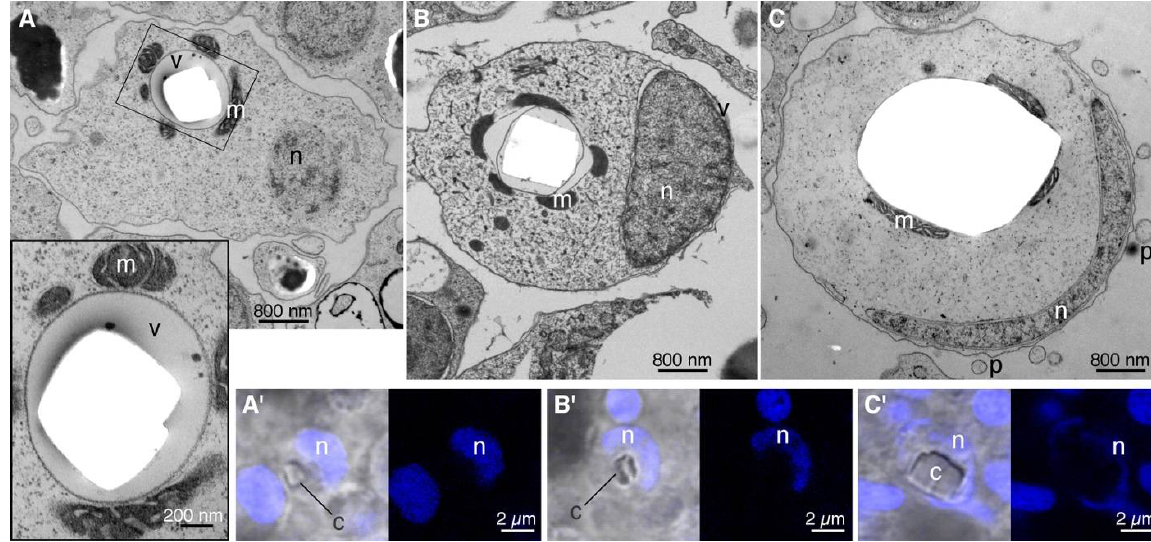
Figure 1. Transmission electron and light microscopy of developing and mature crystal cells. ( A ), ( B ), ( C )—ultrathin sections in TEM. ( A’ ), ( B’ ), ( C’ )—light microscopy of Hoechst labeling (blue) shown superimposed on DIC image (left) and separately (right). ( A )—an early stage of crystal cell development characterized by a very small crystal (<800 nm), rounded nucleus, and elongated shape of the cell. Inset is a magnified boxed region, showing a vacuole with a growing crystal. ( A’ )—a crystal cell at the same stage as shown in ( A ), with a small crystal and bean-shaped nucleus. ( B )—the crystal becomes larger, the nucleus adheres to the cell membrane and begins to adopt cup shape, and the cell rounds up. ( B’ )—a stage corresponding to ( B ) when the nucleus starts to bend. ( C )—mature crystal cell with a large crystal occupying the entire volume of the vacuole and a thin cup-shaped nucleus. ( C’ )—mature crystal cell corresponding to that in ( C ) with a large crystal and a very thin nucleus. c—crystal, m—mitochondrion, n—crystal cell nucleus, p—crystal cell protrusions, v—vacuole with growing crystal.